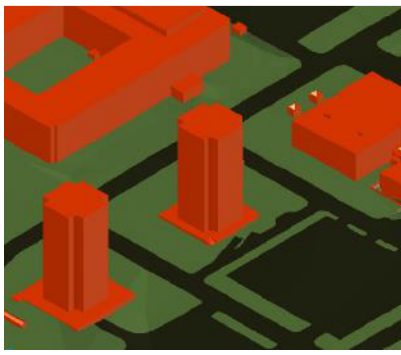
Table 1: Results of Context-Aware algorithm compared to